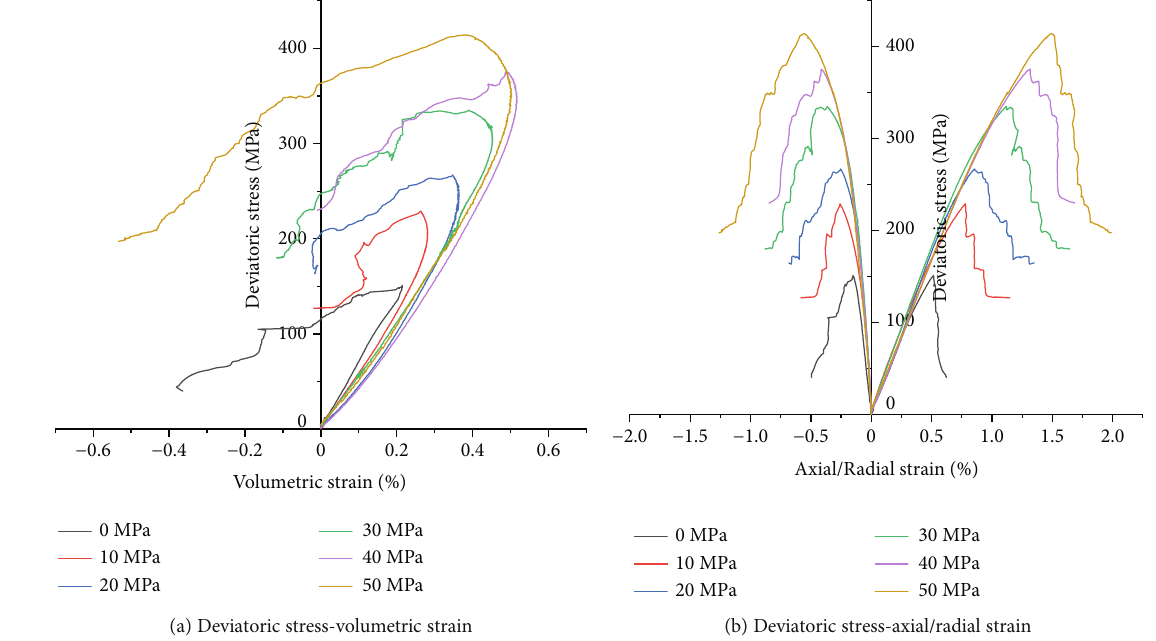
Figure 4: Stress-strain curves of cores under varying con fi ning pressures in triaxial compression tests.